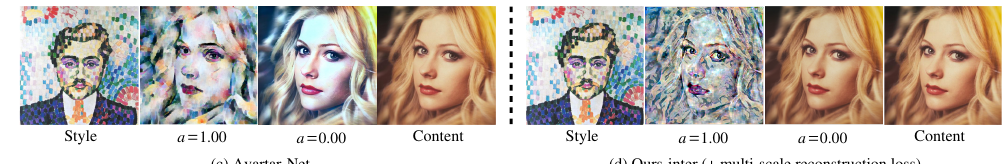
Figure 6. Style-content interpolation of our methods and Avatar-Net [13]. Avartar-Net cannot reconstruct content image when a = 0.00, Ours-intra ( a ) and Ours-inter ( b ) achieved a smooth style interpolation from content image to style image with a slight tone mismatch when a = 0.00. When Ours-inter ( d ) used additional multi-scale reconstruction loss of Avatar-Net, the image tone can be also matched to the content when a = 0.00, while the original Avatar-Net ( c ) has some color bias.